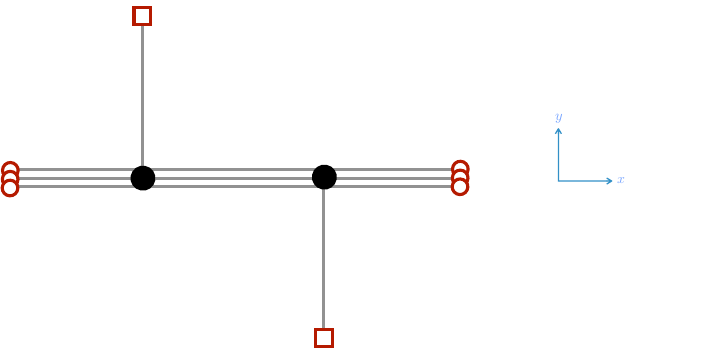
Figure 12 . The deformed X 1 ,N theory in the large N limit. The system becomes that of N (1 , 1) 5-branes on which two (1 , − 1) 5-branes